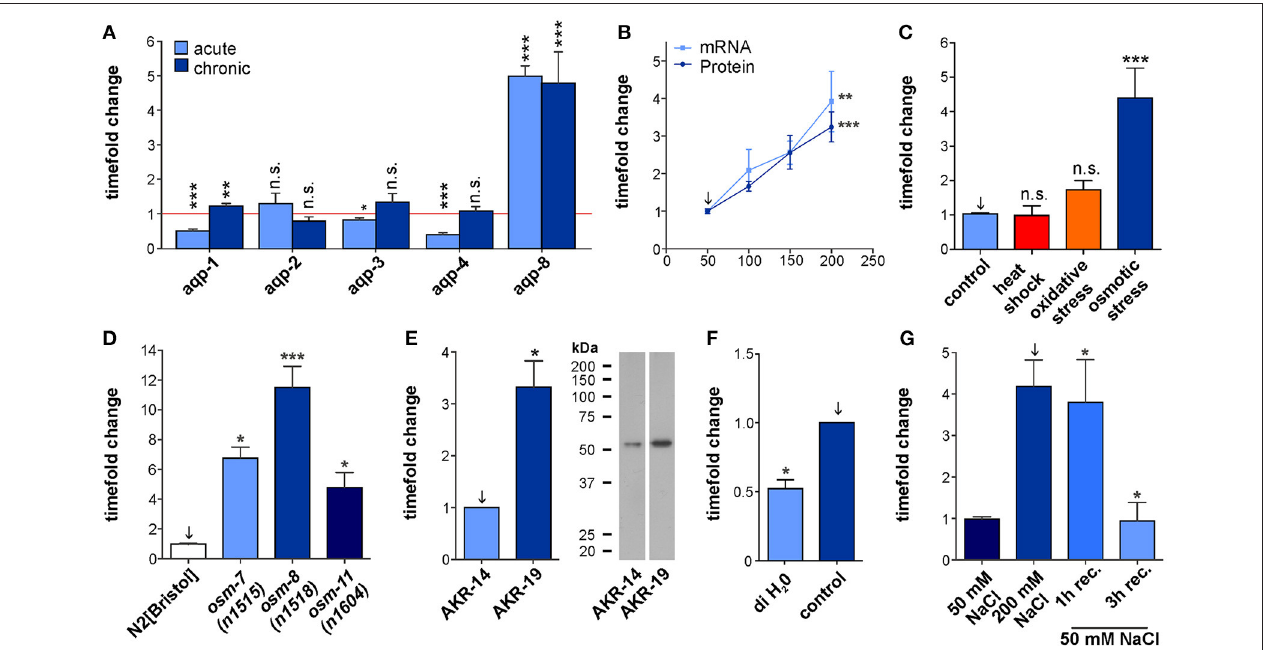
FIGURE 1 | Characterization of aqp-8 expression. (A) Effects of acute and chronic osmotic stress on the various aquaporines expressed in the intestine and the excretory cell. The amount of mRNA was measured by qPCR techniques in N2[BRISTOL] background. Student’s t -test was performed against isosmotic